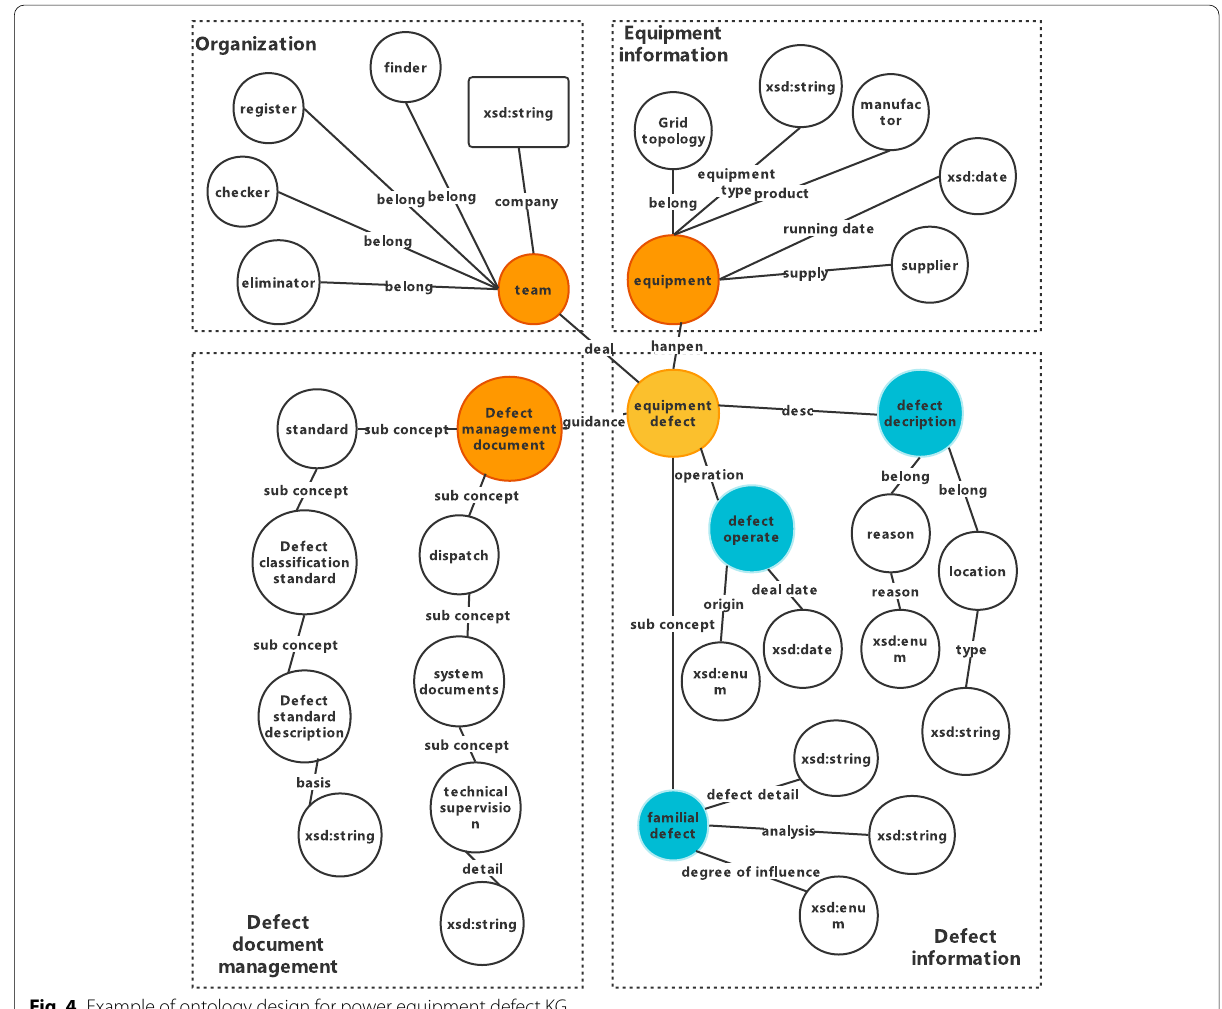
Fig. 4 Example of ontology design for power equipment defect KG